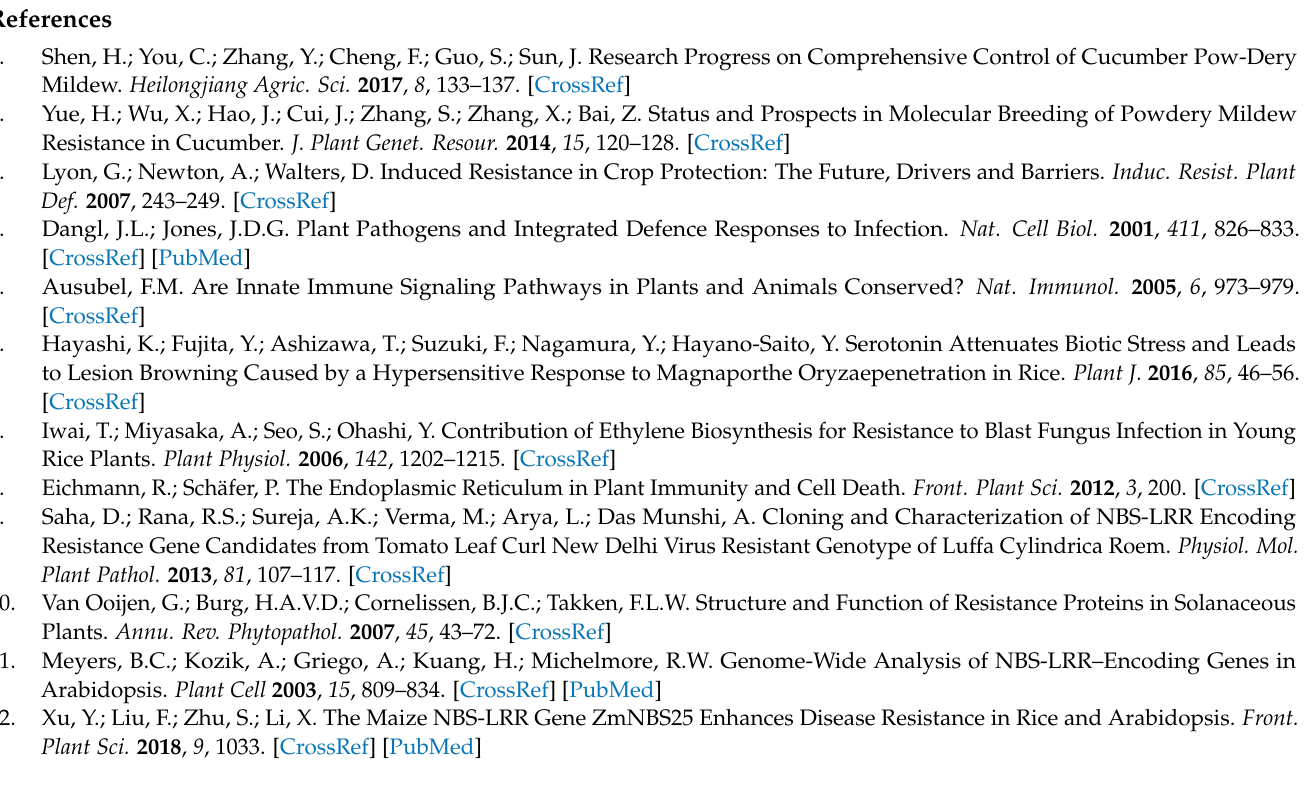
CsRSF1 CDS encoding a protein. Figure S2: Nucleotide and deduced amino acid sequences of cucumber CsRSF2 CDS encoding a protein. Figure S3: Chromosome location of NBS-LRR superfamily in the cucumber. Figure S4: The structural domain of CsRSF protein. Table S1: The primers of PCR used in this study. Table S2: The primers of qRT-PCR used in this